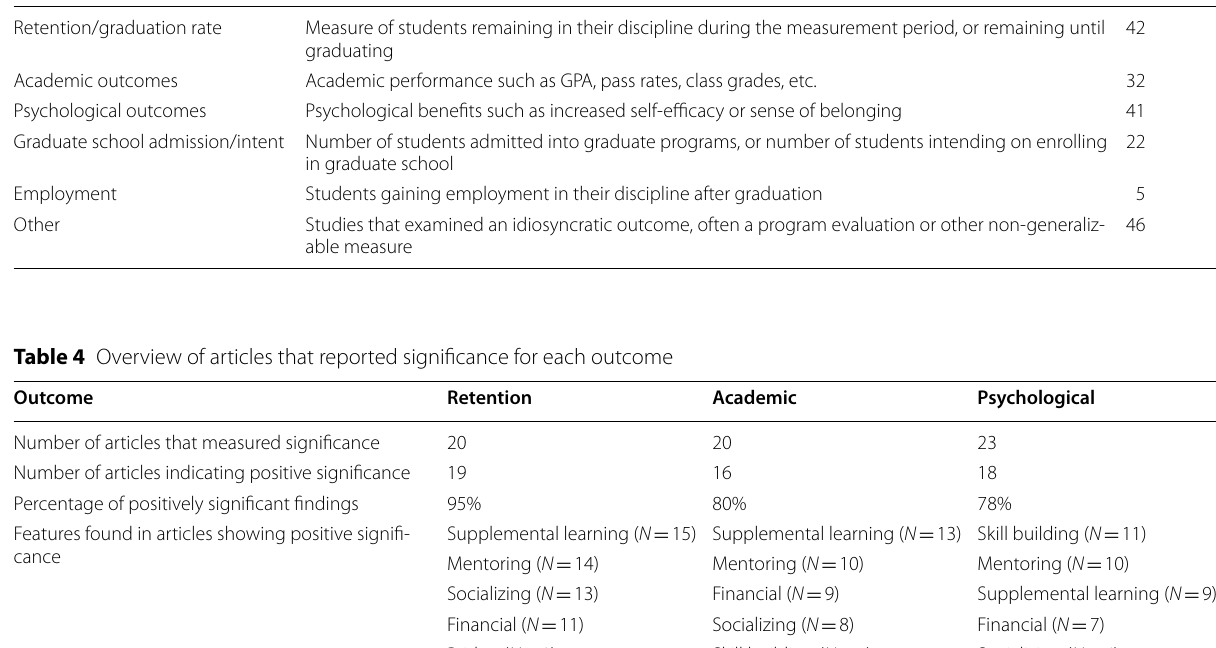
Table 3 Most frequently studied program outcomes in the literature Outcome Definition Retention/graduation rate